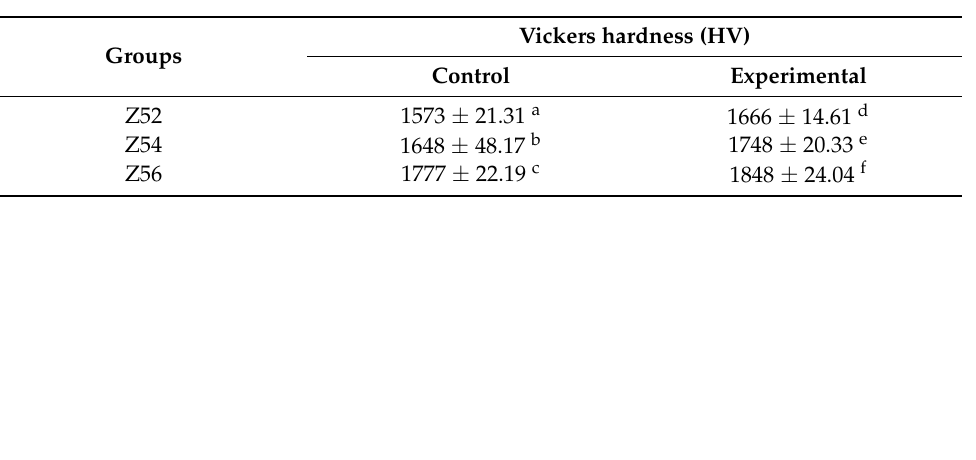
Table 4. Vickers hardness of printed zirconia; different letters represent significant differences ( p < 0.05).